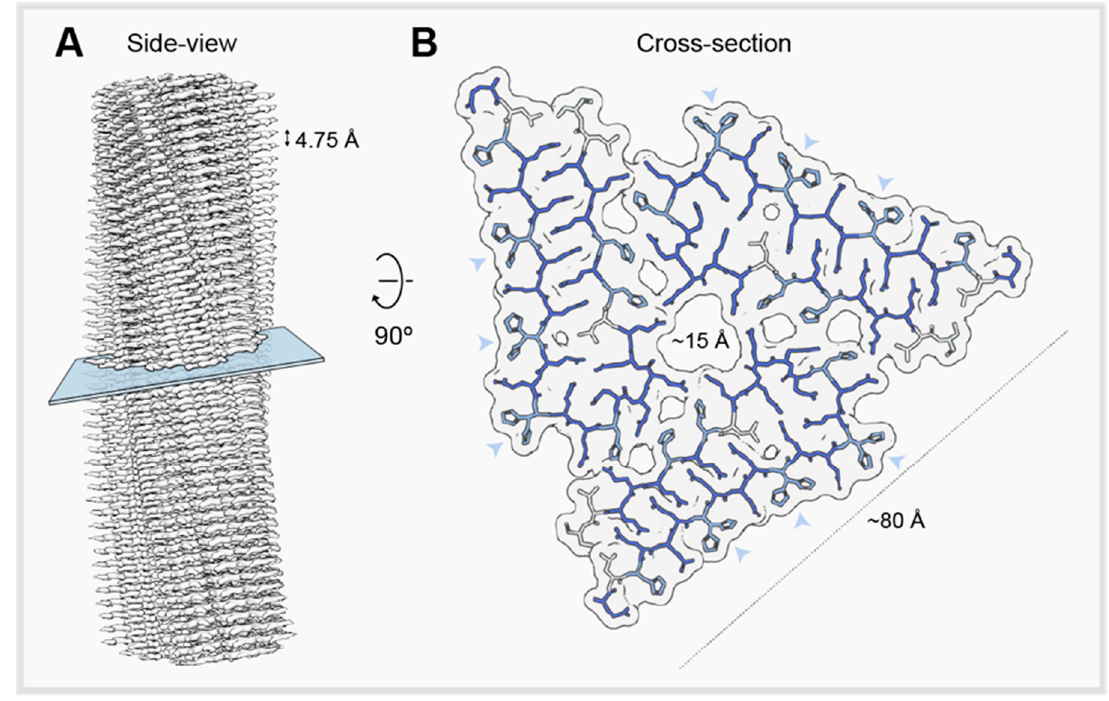
Figure 1. General view of the Orb2 amyloid structure. Side view of the reconstructed Orb2 amyloid core showing the ~4.75 Å separation between β -strands, typical of the amyloid fold ( A ), and cross-sectional view of one molecular layer of the calculated atomic model ( B ) [42]. Glutamines are colored in dark blue, while histidines are colored in light blue. In some histidine residues, a major and minor occupancy, alternative sidechain conformations are shown (arrow heads). Leucine and serine residues are represented in gray.